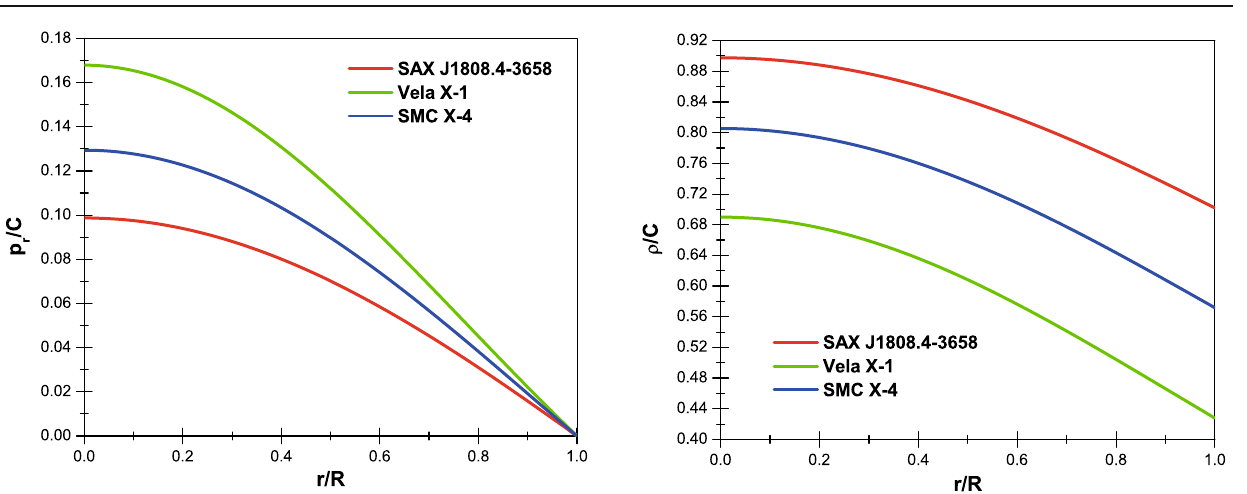
Fig. 7 The dimensionless density against the fractional radius for α = 0 .